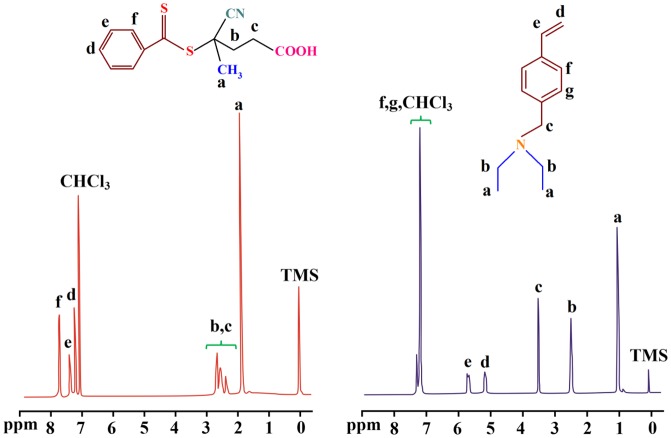
The 1H NMR spectra of the synthesized RAFT agent and VEA monomer (CDCl3, 25 °C).